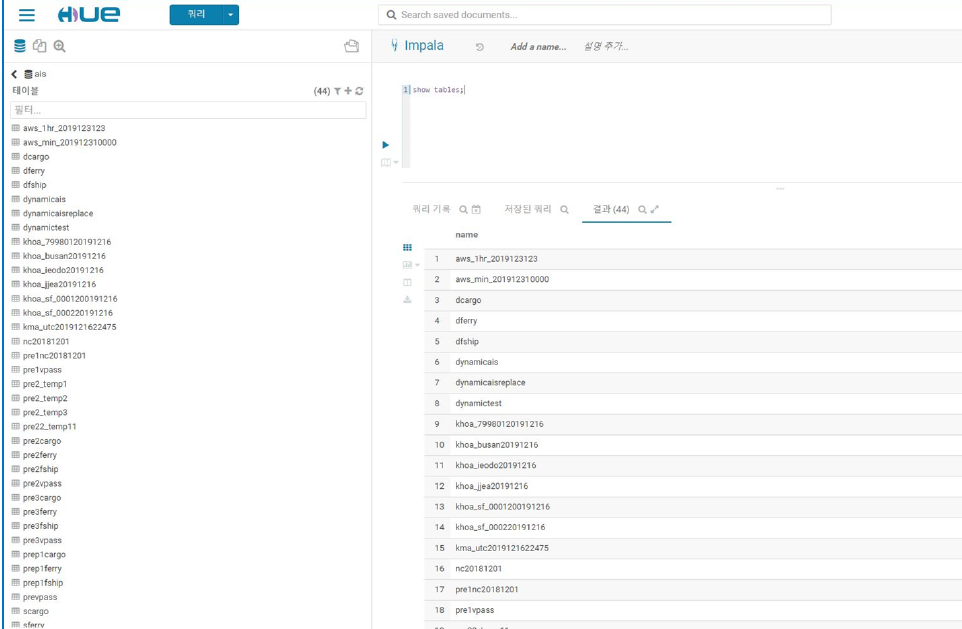
Figure 5. The meaning description of field names in the schema of Figure 4.